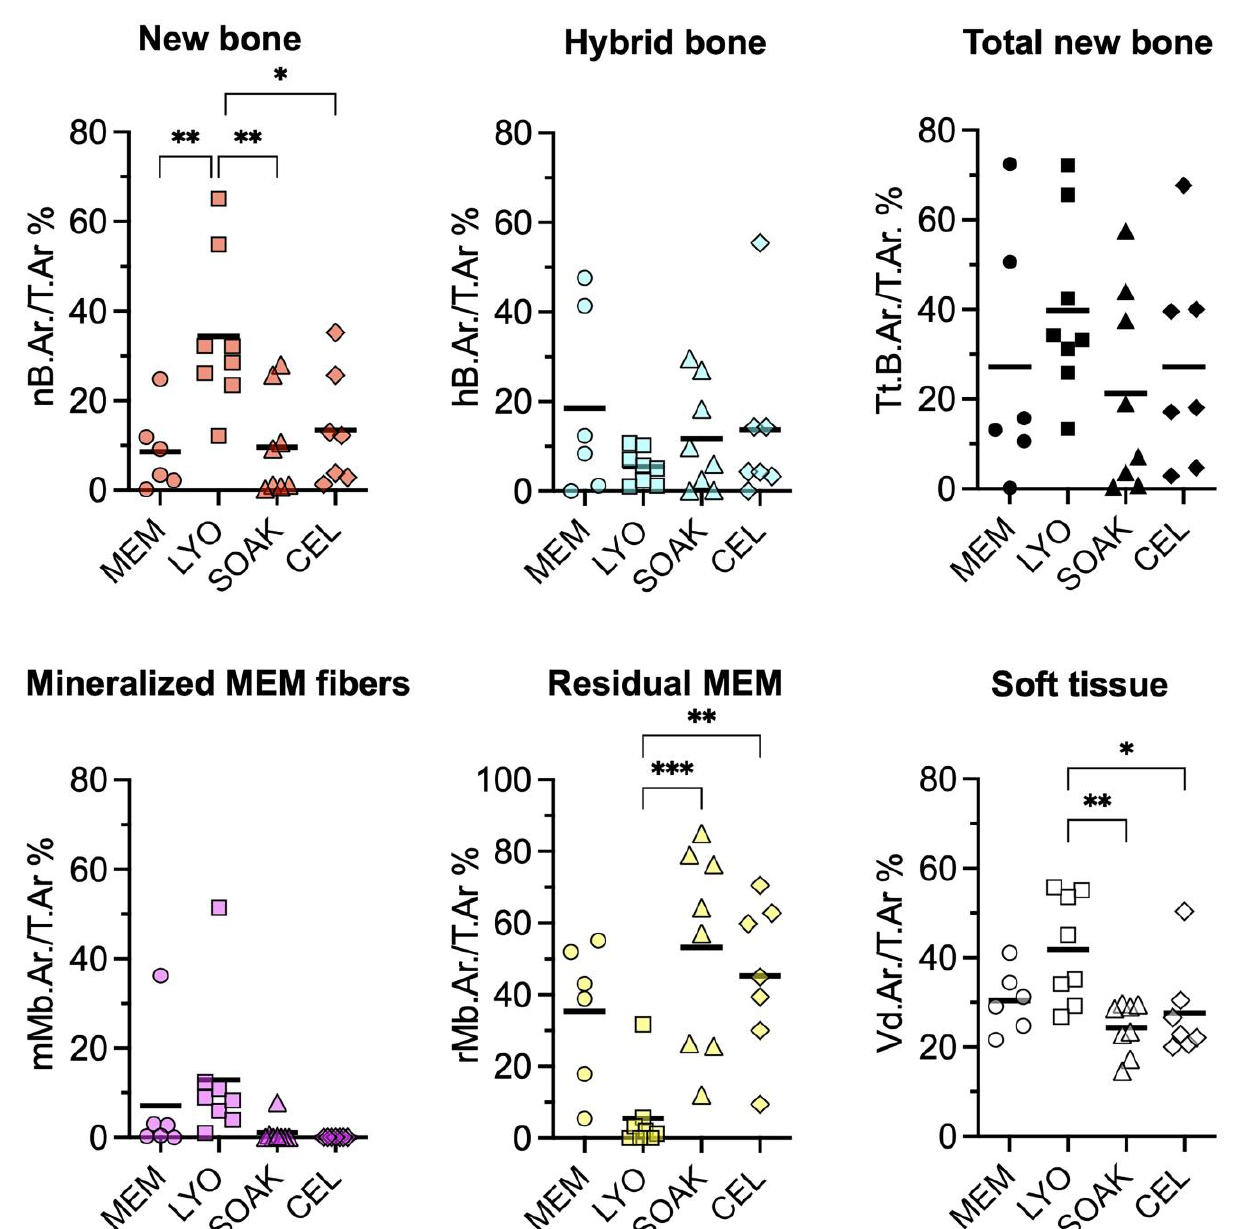
Figure 6. Histomorphometry of central defect regions. Quantification of histomorphometric parameters: T.Ar., Total Area; nB.Ar., New Bone Area; hB.Ar., Hybrid Bone Area; Tt.B.Ar., Total New Bone Area (New Bone + Hybrid Bone Area); mMb.Ar., Mineralized Membrane Area; rMb.Ar., Residual Membrane Area; Vd.Ar., Void Area; MEM, native membrane; LYO, lyophilized membrane with conditioned media; SOAK, soaked membrane with conditioned media; CEL, membrane with rMSC. Data represent means (n ≥ 5). * p < 0.05, ** p < 0.01, *** p < 0.001.